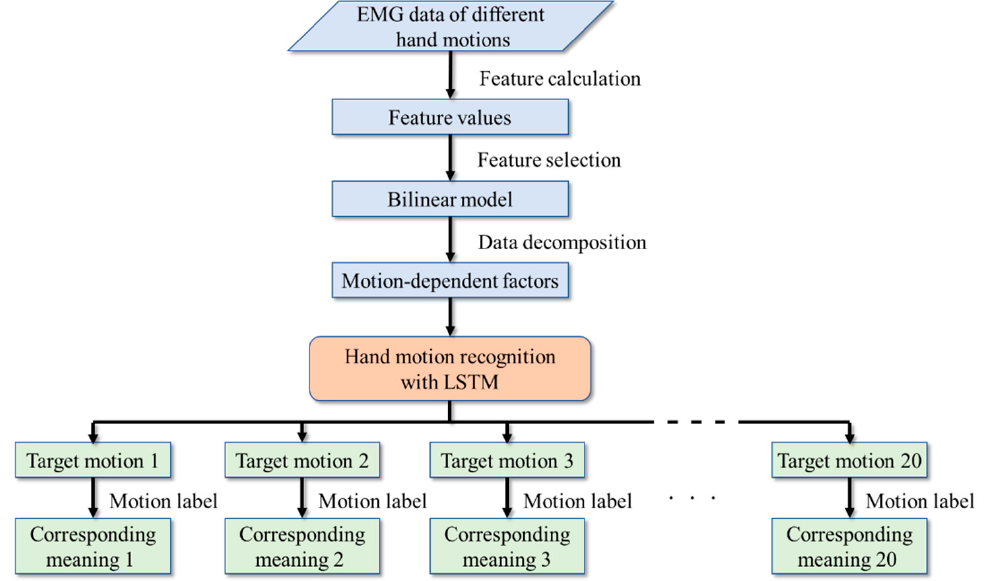
Figure 1. The flow chart of the system.